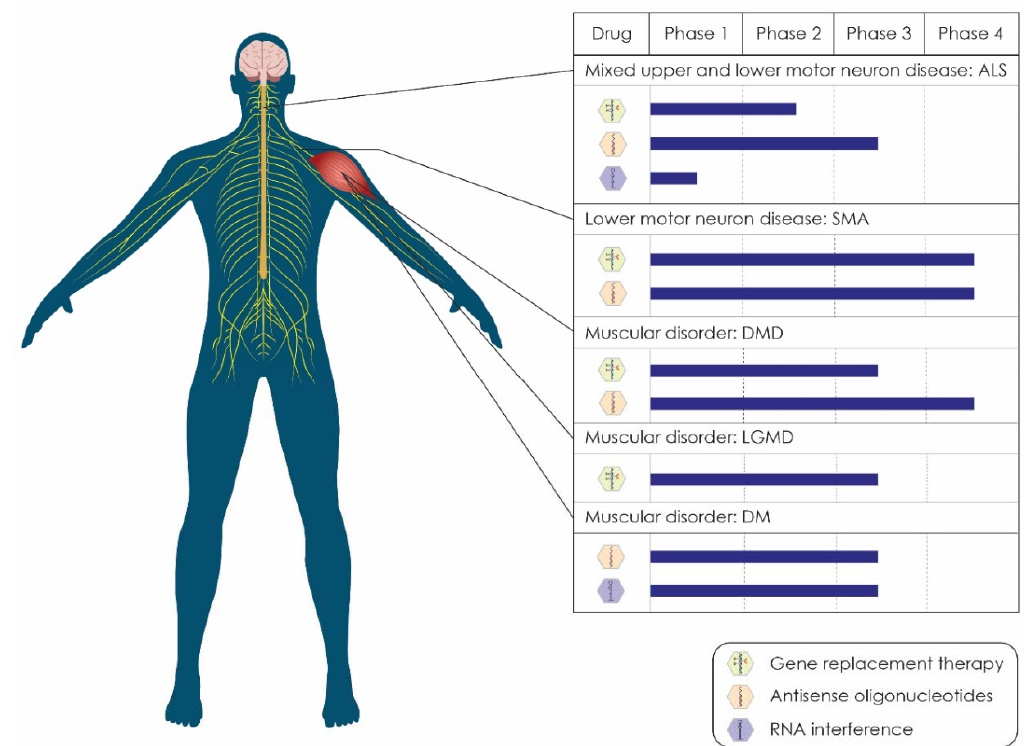
Figure 1. Status of the most advanced gene therapies for motor neuron diseases and muscular dystrophies. In ALS, in which the pathology is located both in upper and lower motor neurons, the most advanced GRT has reached phase 2, the most advanced ASO has reached phase 3, and the most advanced RNAi drug has reached phase 1. In SMA, a disease of the lower motor neurons, both a GRT and an ASO, have gained FDA approval and are currently tested in phase 4 clinical trials. In DMD, a disorder that targets the muscles, GRTs are presently tested in phase 3 clinical trials, whereas ASOs have gained FDA approval. In LGMD, which is also a muscle disorder, GRTs are currently tested in phase 3 clinical trials. In DM, both ASOs and RNAi drugs have reached phase 3 of clinical trials. Abbreviations: ALS, amyotrophic lateral sclerosis; GRT, gene ‐ replacement therapy; ASO, antisense oligonucleotide; RNAi, RNA interference; SMA, spinal muscular atrophy; DMD, Duchenne muscular dystrophy; LGMD, limb ‐ girdle muscular dystrophy; DM, myotonic dystrophy.